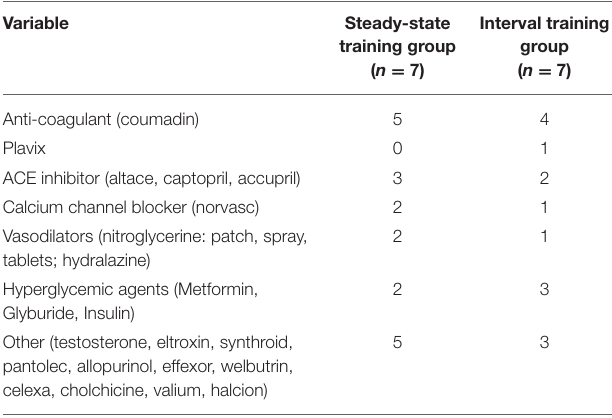
TABLE 1 | Participant characteristics (values are means ± SD).